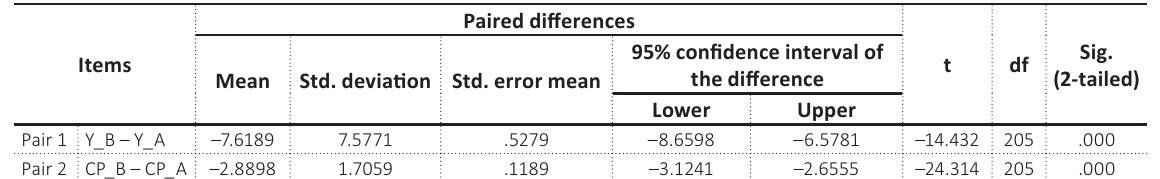
Table 3. Comparison of income and expenditure difference Items